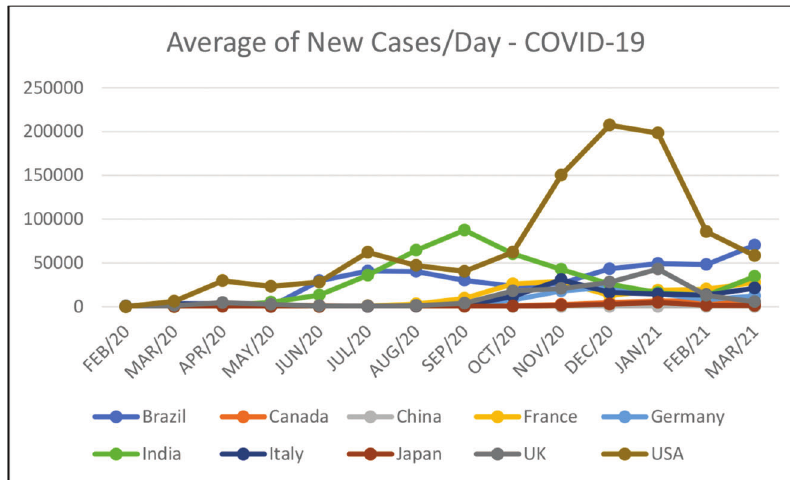
Figure 1 - Average of New Cases/Day –